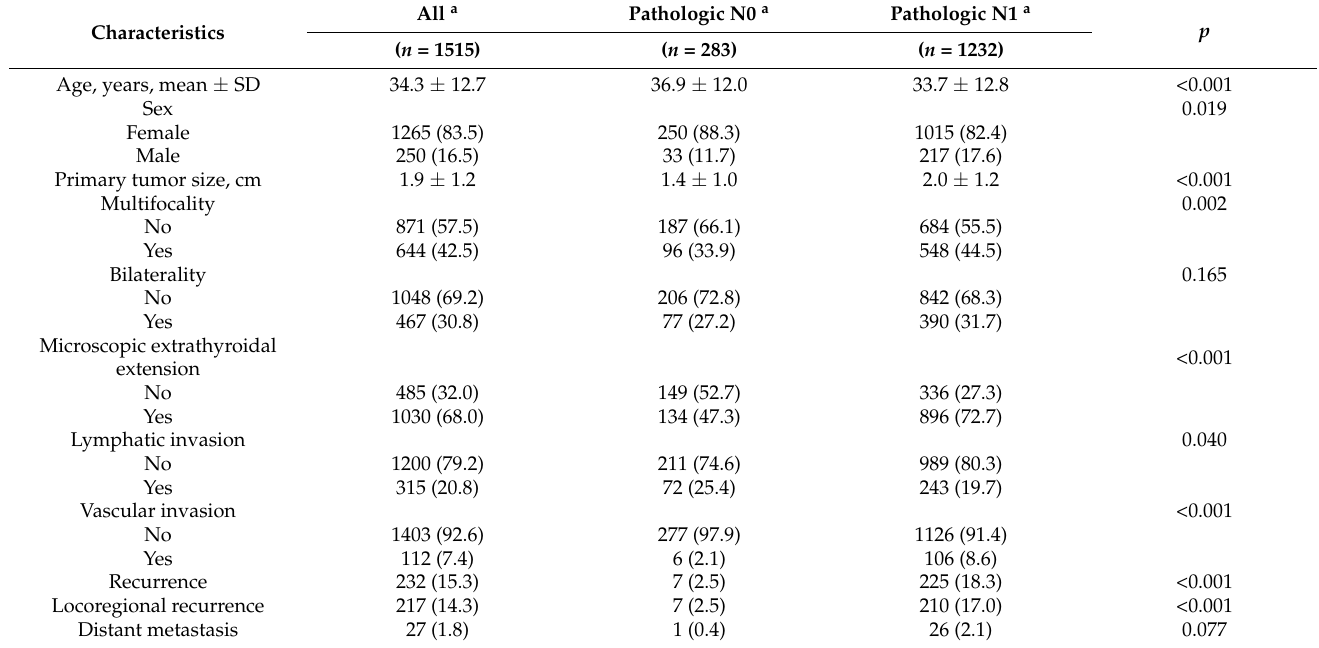
Table 4. Comparison of demographic characteristics between pathologic N0 and N1 patients.